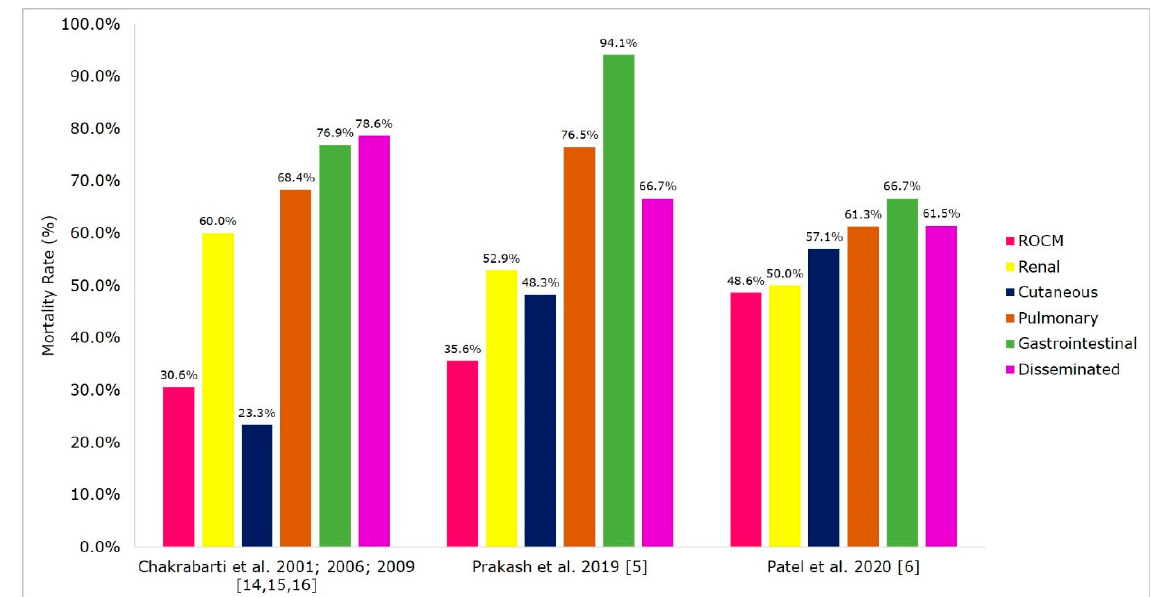
Figure 5. Morality rate in clinical forms of mucormycosis in India. Abbreviations: ROCM, rhino-orbital-cerebral mu- cormycosis.